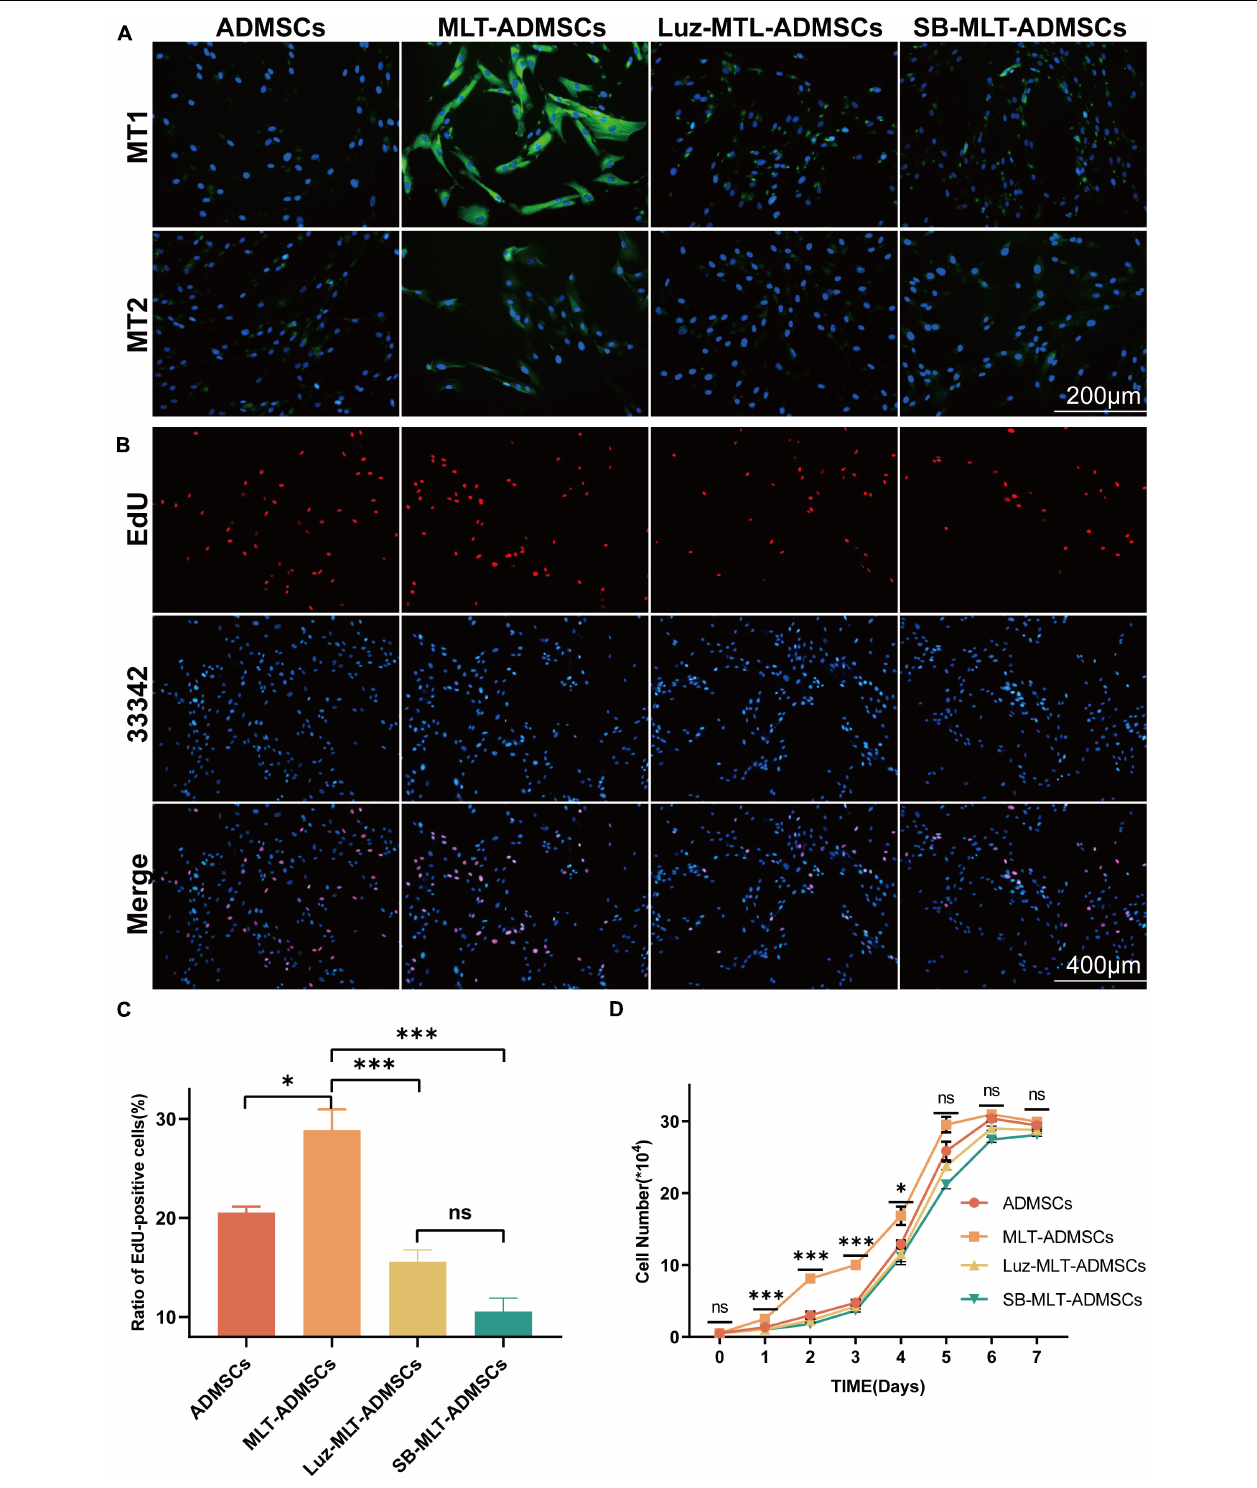
FIGURE 8 | MLT depends on the MT1/MT2 receptor and activates the TGF- β pathway to promote the viability of ADMSCs. (A) MT1/MT2 immunofluorescence staining. (B) EdU staining. (C) EdU quantitative analysis. (D) Cell growth curve. Values in (C,D) are the mean ± SE; n = 3 per group; ns > 0.05, ∗ p < 0.05, ∗∗∗ p < 0.001 determined by a repeated-measures